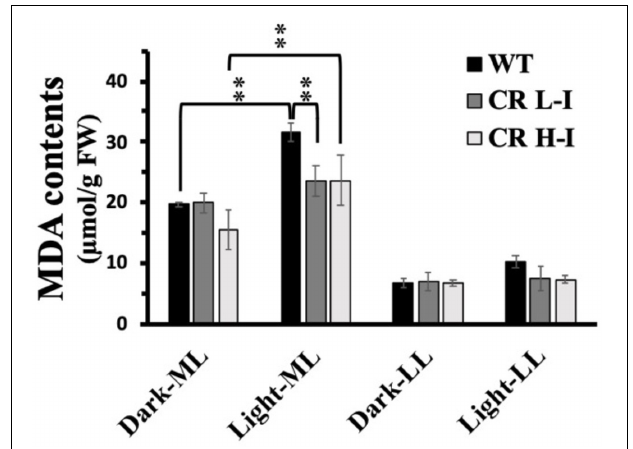
FIGURE 5 | Comparison of malondialdehyde (MDA) content in wild-type and CAO RNAi transgenic lines. Moderate light (ML) (850 µ mol photons m − 2 s − 1 ) and low light (LL) (200 µ mol photons m − 2 s − 1 ) grown wild-type (WT), CR L-I (Chl a/b = 4.5–6.5), CR H-I (Chl a/b = 6.5–8.5), and CR V-H (Chl a/b 8.5 or above) transgenic plant leaves were exposed to growth light for 4 h. The MDA content was measured before the light illumination (Dark-ML or Dark-LL) and after the light illumination (Light-ML or Light-LL). All experiments were done using fully expanded leaves from the top of 4–5 weeks old plants. Results represent the average and SD of three independent measurements. ∗∗ , values are significantly different at P < 0.05 between experimental